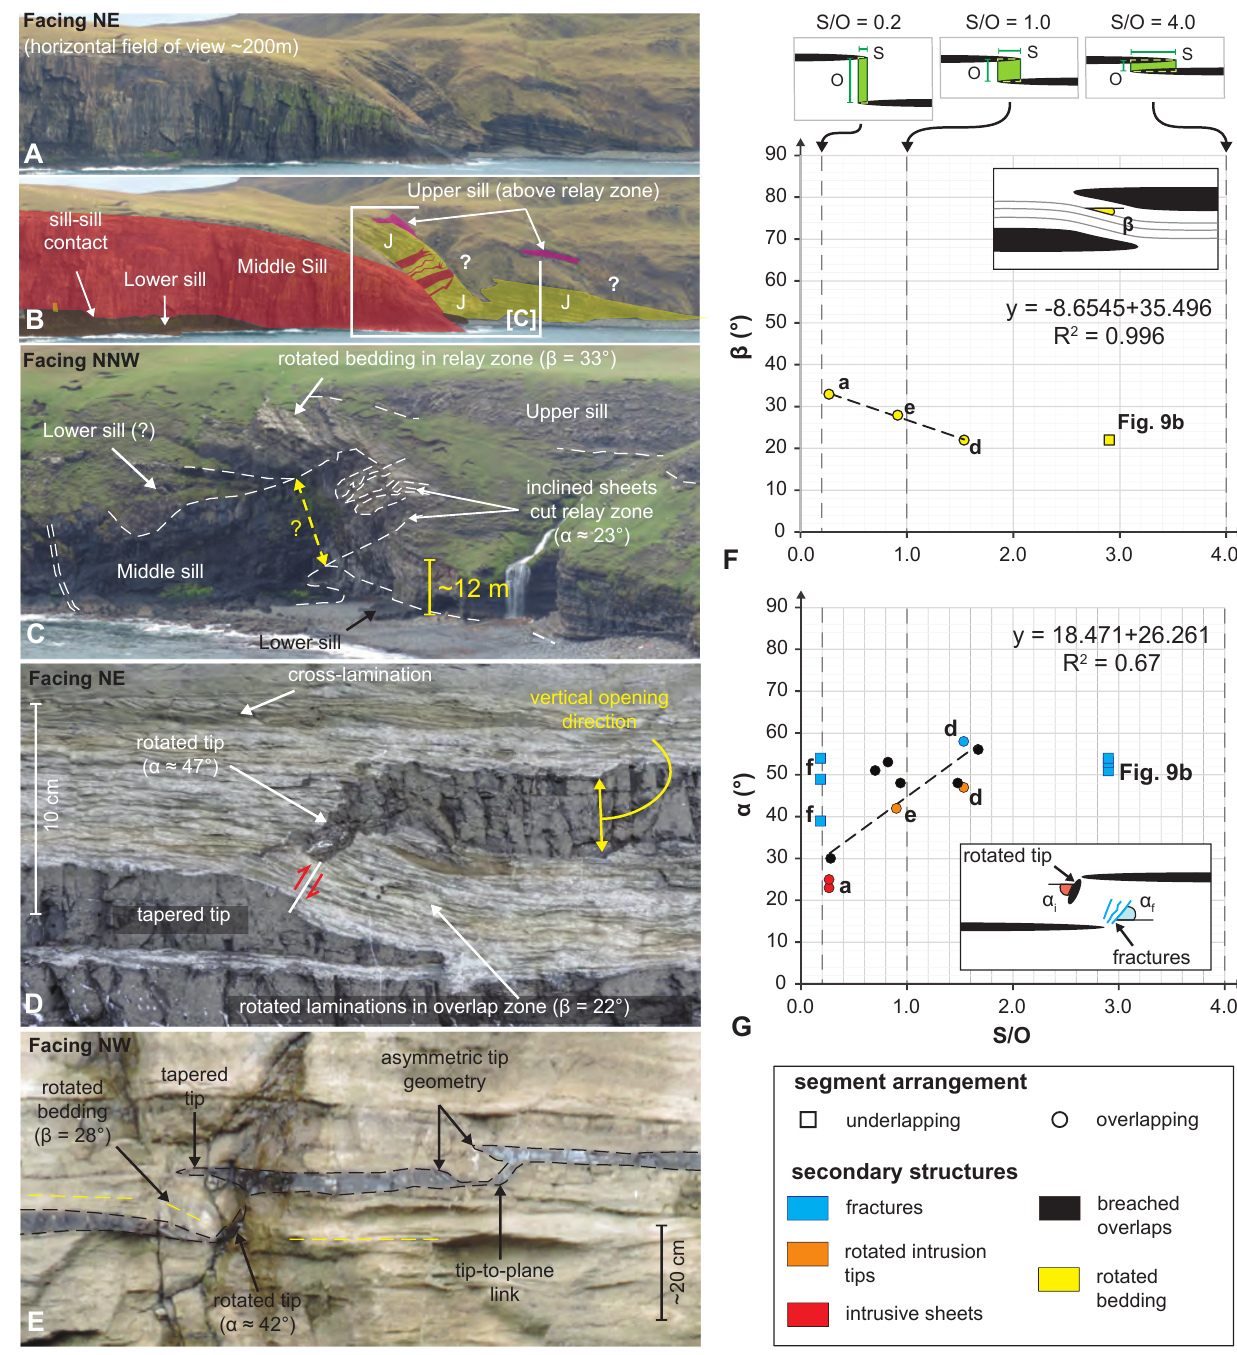
(Figure 8; and A–B on Figure 11A). Only three of the measured overlap zones are intact (i.e. not breached, e.g. Figure 8D–E), and together with the breached over- lap zones they fit a positive near-linear power-law re- gression with an R 2 value of 0.83 (Figure 11A), sug- gesting that overlapping segments follow elastic-brittle propagation